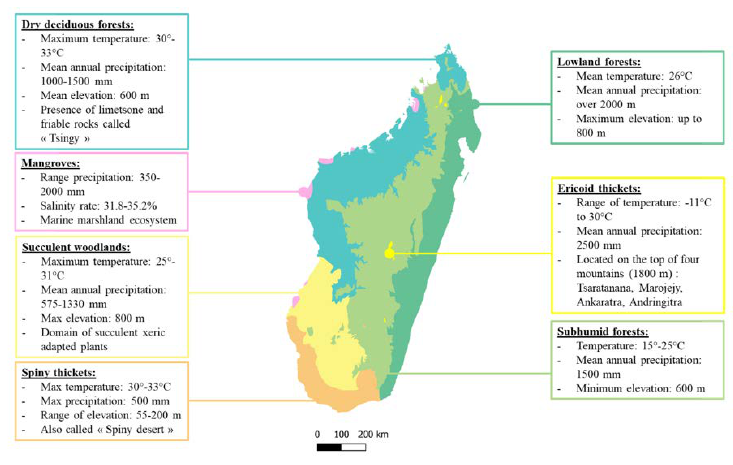
Figure 8. Map of the seven ecoregions of Madagascar adapted from WWF’s ecoregion in Burgess et al.